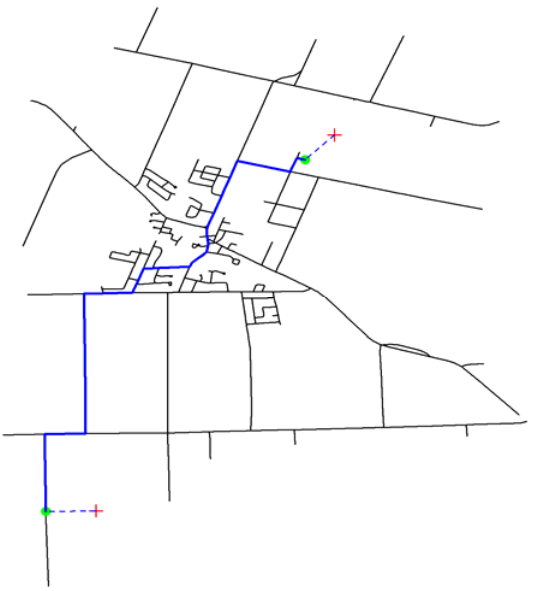
Figure 14. An interactive example for finding the shortest path with shp2graph and igraph (Ontario road data).